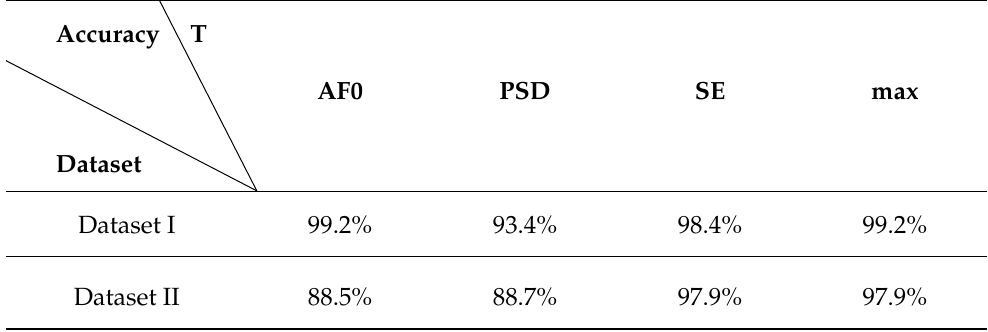
Table 2. Accuracy comparisons of MGRALN without auxiliary pipelines on the dataset I and dataset II when the training ratio is 80%.